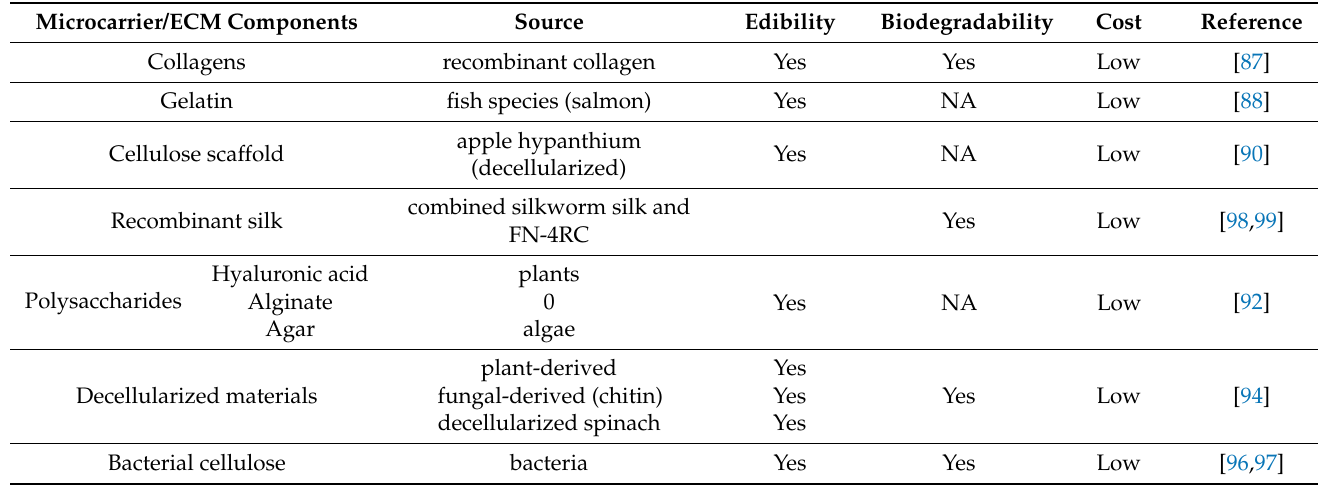
Table 2. List of non-animal derived microcarrier/ECM components used in scaffold